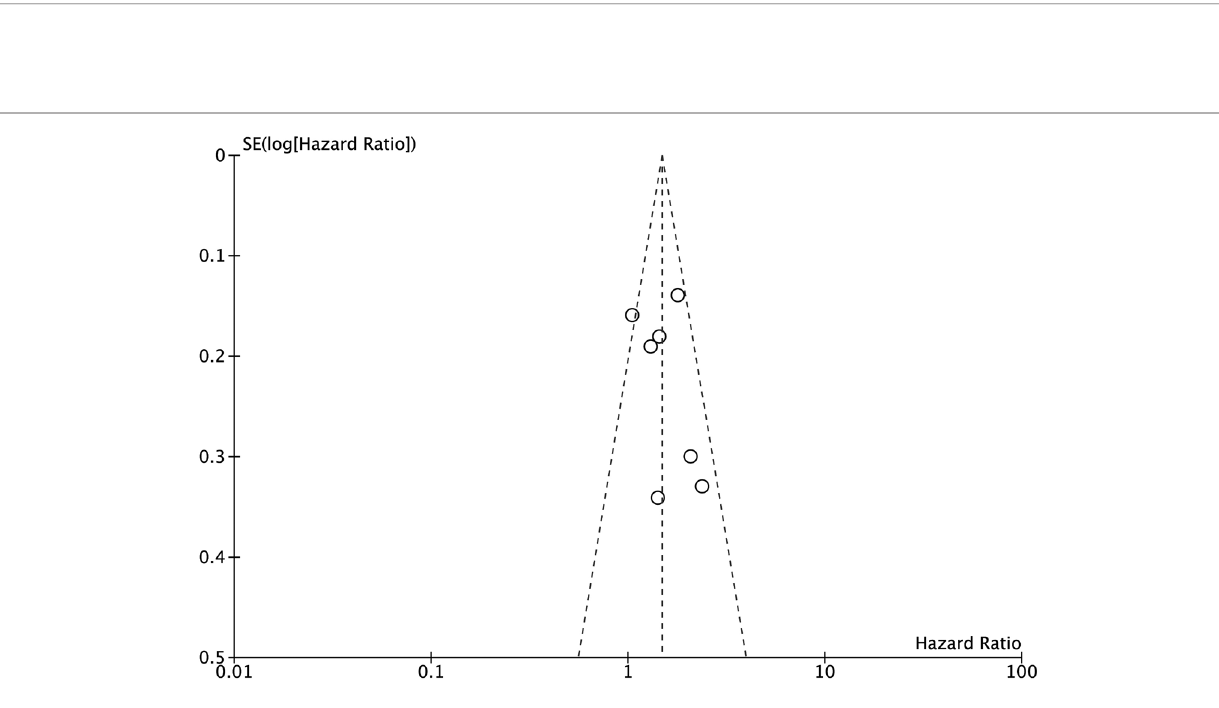
FIGURE 3 | Overall survival and disease free survival between the Larger IBL group and the Smaller IBL group. Note: IBL: intraoperative blood loss, mL.